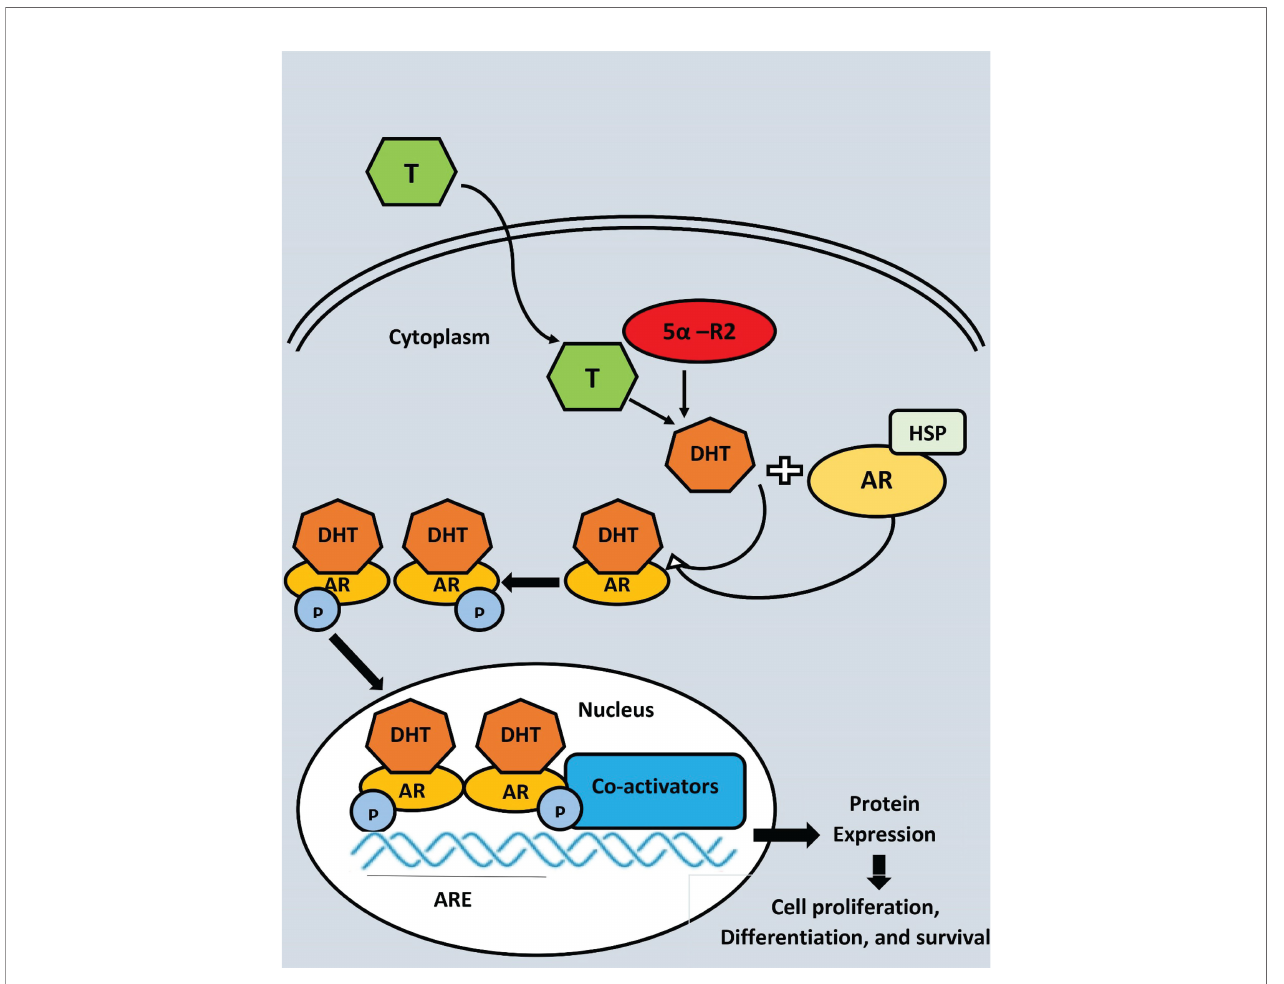
FIGURE 3 | Androgen receptor (AR) ligand-dependent gene transactivation mechanism 5-reductase converts testosterone (T) to dihydrostosterone (DHT) in theprostate epithelical cell. DHT binding to AR causes dissociation of the AR-HSP (Heat shock protein) complex, dimerization, and nuclear translocation. AR binds to androgen response elements (ARE) in DNA and recruits co-activators to enhance transcription, where P, Phosphate